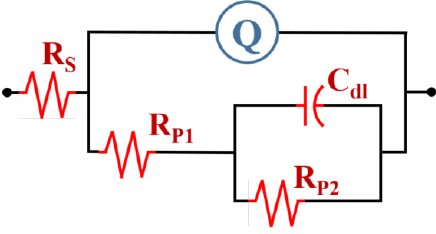
Figure 3. The equivalent circuit model used to fit EIS data shown in Figures 1 and 2. Table 1. Electrochemical impedance spectroscopy parameters obtained for the different Ti-54M alloys in 2M HCl solutions.